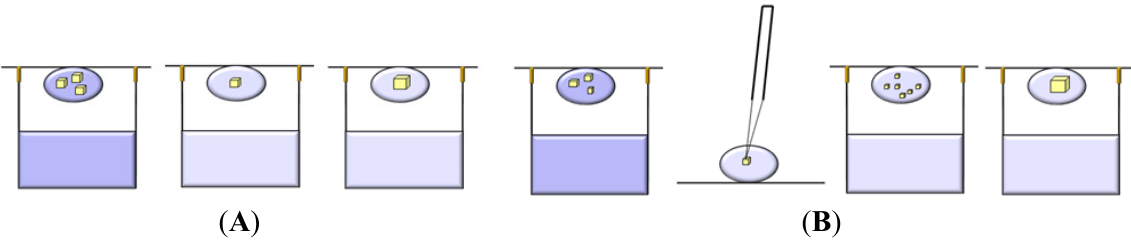
Figure 11. Seeding methods. ( A ) Macroseeding method. One crystal is transferred from a solution in which nucleation and initial growth occurred to a less supersaturated solution to slowly continue the growth; ( B ) Microseeding method. Crystals are fished from a supersaturated solution where nucleation and initial growth occurred, then they are crushed and the small seeds are transferred to a less supersaturated growth